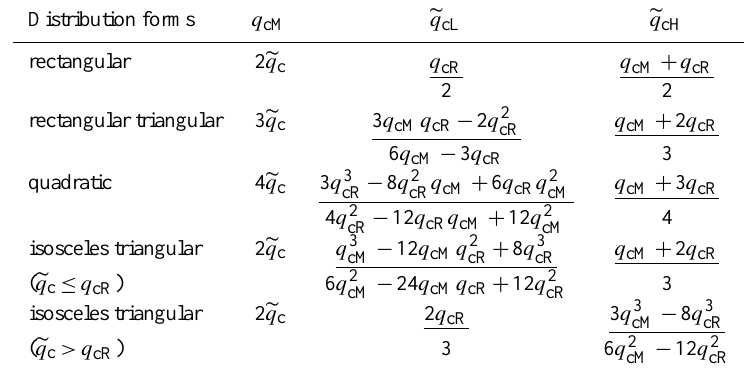
Table 2. Maximum values of CWC ( q cM ) and local mean values of CWC in low ( e q cL ) and high ( e q cH ) CWC regions for four different CWC PDF forms. The threshold value allowing precipitation formation is identified with q cR